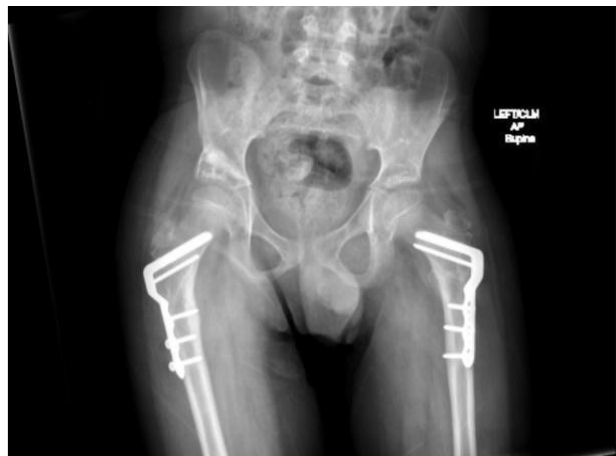
Figure 4 . Radiograph at 18-Months in Postoperative, the Patient Displays Healed Osteotomies; The Distal Femoral Shaft Screws Are Backing Out Bilaterally.